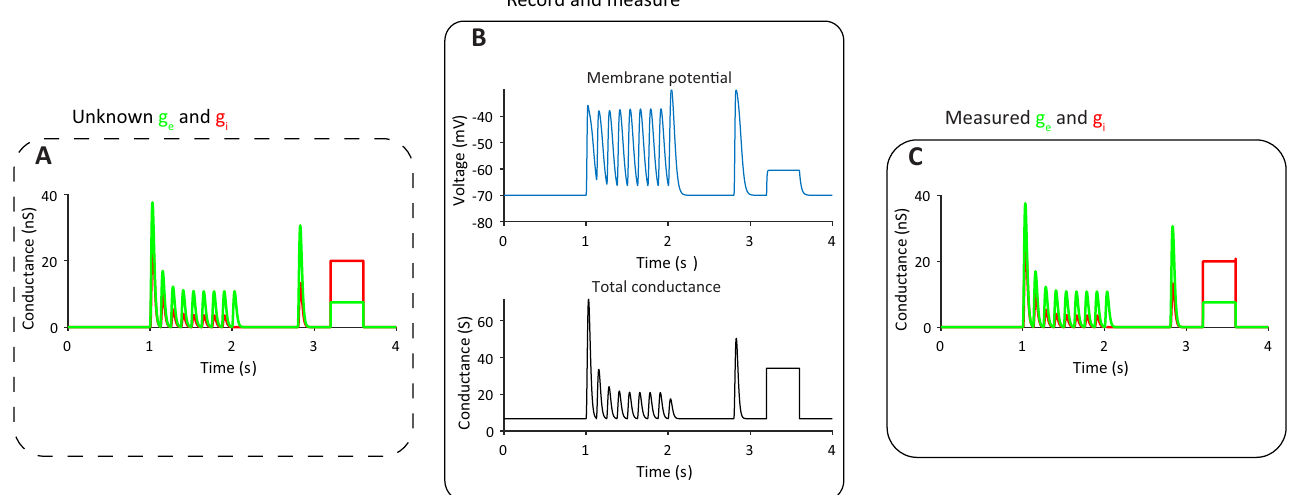
Fig 1. G e and g i can be obtained from V(t) and total g. A. Simulation of correlated excitatory (green) and inhibitory (red) synaptic inputs (inhibition delayed by 4 ms after excitation), which depressed according to a mathematical description of short-term synaptic depression (STD, Markram and Tsodyks, 1997). These are the inputs the method aims to reveal. B. Membrane potential simulation of a passive point neuron (R = 300M Ω , C = 0.15nF, Euler method, dt = 0.0005s) receiving the inputs in A, with the total conductance shown below. We assume that these two vectors are measurable. A short test current pulse was injected at the early part of the trace. C The result of transforming V(t), its derivative (not shown) and the total synaptic conductance into g e and g i using Eqs (1 and 2).